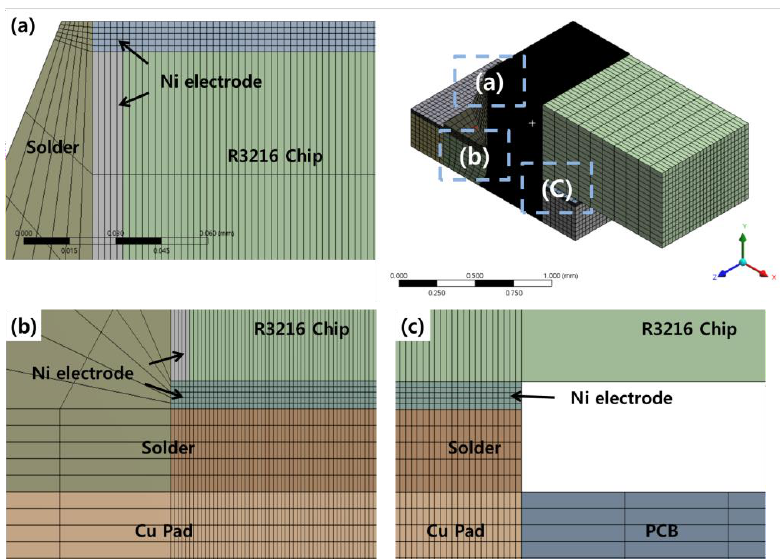
Figure 2. 1/4 3D model of plain and epoxy solder specimens. ( a ) plain solder modeling; ( b ) epoxy solder joint modeling.